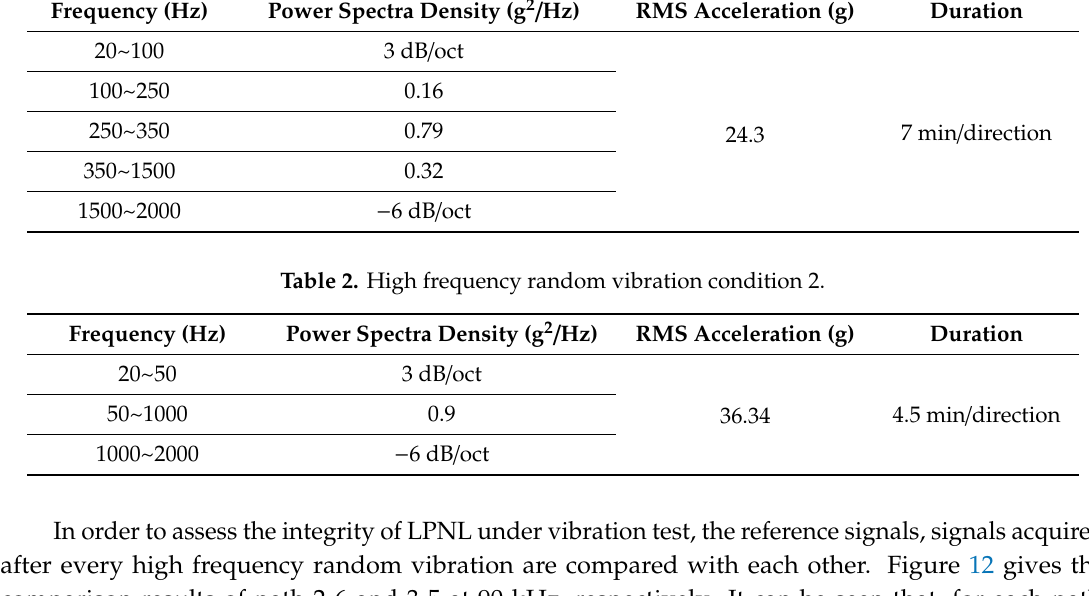
Figure 12. Signal comparison results of paths 2-6 and paths 3-5. ( a ) Paths 2-6. ( b ) Paths 3-5.